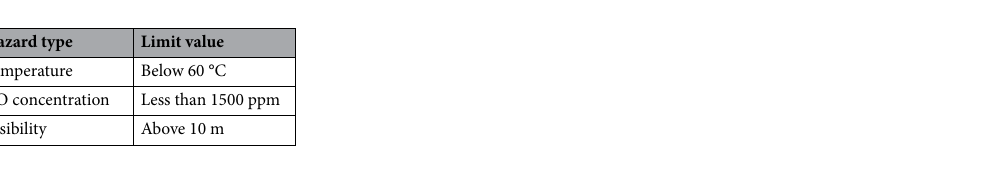
Table 3. Criteria for the safe environment of personnel in a fire scene in